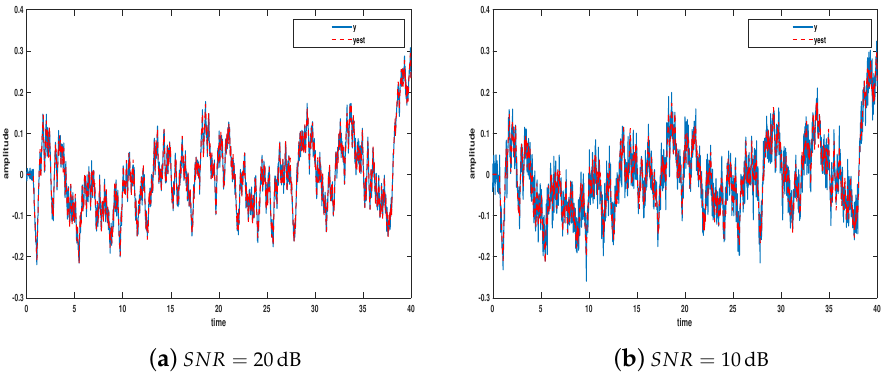
Figure 8. The output error of example 2. The true output y ( t ) and the simulated output sequences ˆ y ( t ) of the estimated model are plotted for the two levels of noise in Figure 9.